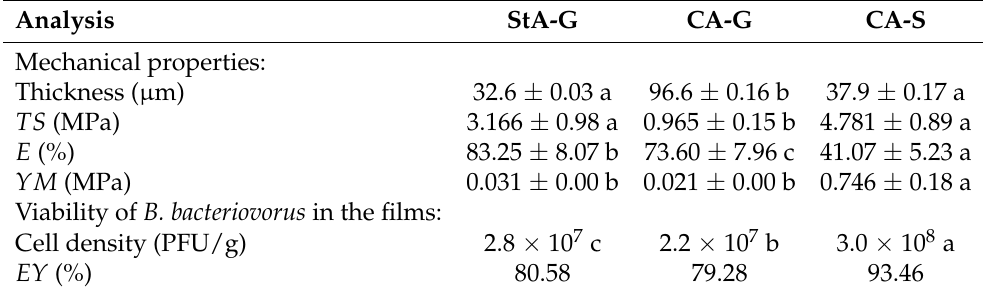
Table 1. Mechanical properties and viability of B. bacteriovorus HD100 in the